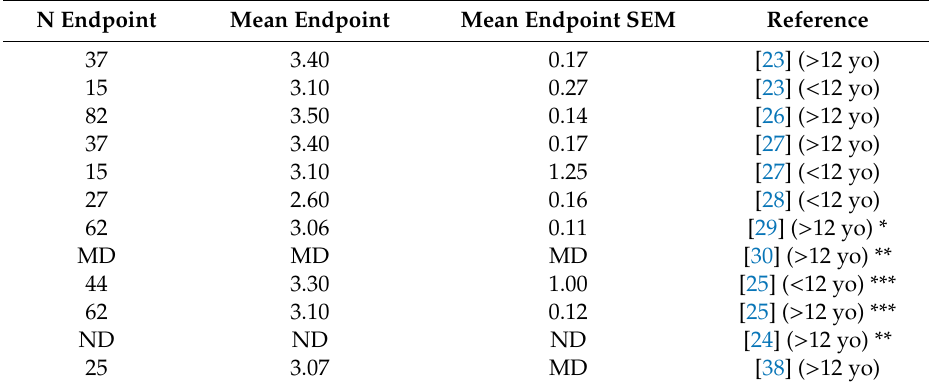
Table 2. Placebo-treated groups with FXS in failed clinical trials: substantial placebo e ff ect in endpoint